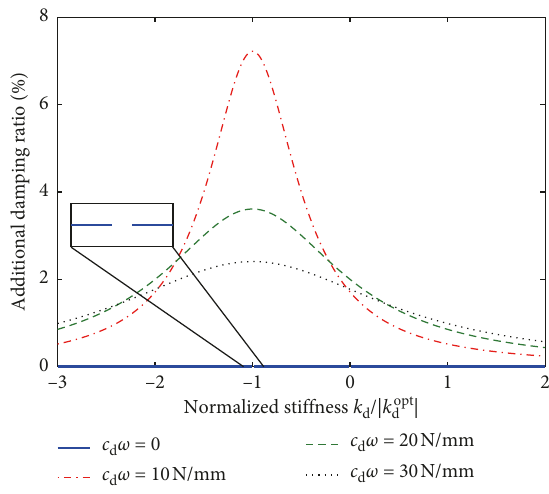
Figure 16: Additional modal damping ratio for the stay cable with various levels of damping.